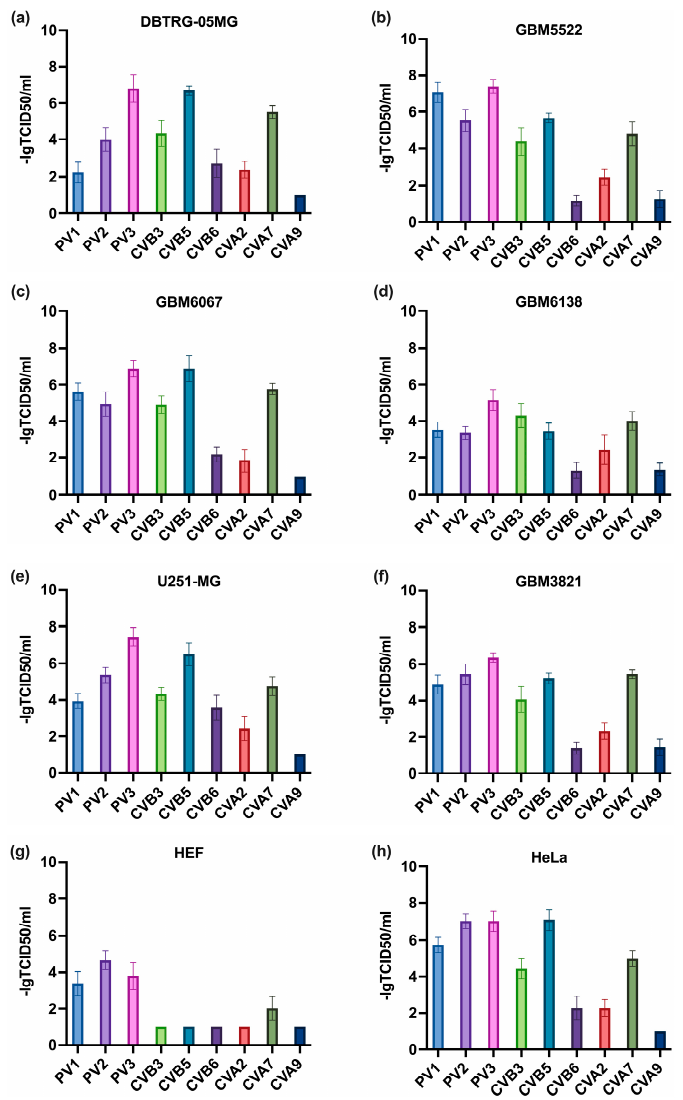
Figure 1. CVB5 exhibits the highest oncolytic activity towards glioblastoma multiforme (high grade) cell lines, stable glioblastoma cell lines: DBTRG-05MG ( a ), U251-MG ( e ), primary gliomas: GBM3821 ( f ), GBM5522 ( b ), GBM6067 ( c ), GBM6138 ( d ), and Hela cell line ( h ), as cancerous non-glioma cell line, and HEF ( g ) as non-cancerous cell line. The cells were seeded 24 h prior to infection and inoculated with MOIs from 0.001–1000 with polioviruses type 1–3 (PV1–3), Coxsackievirus A (CVA), or B (CVB). Cell viability was assessed 48 h later by MTT test. The depicted values are means ± S.D.